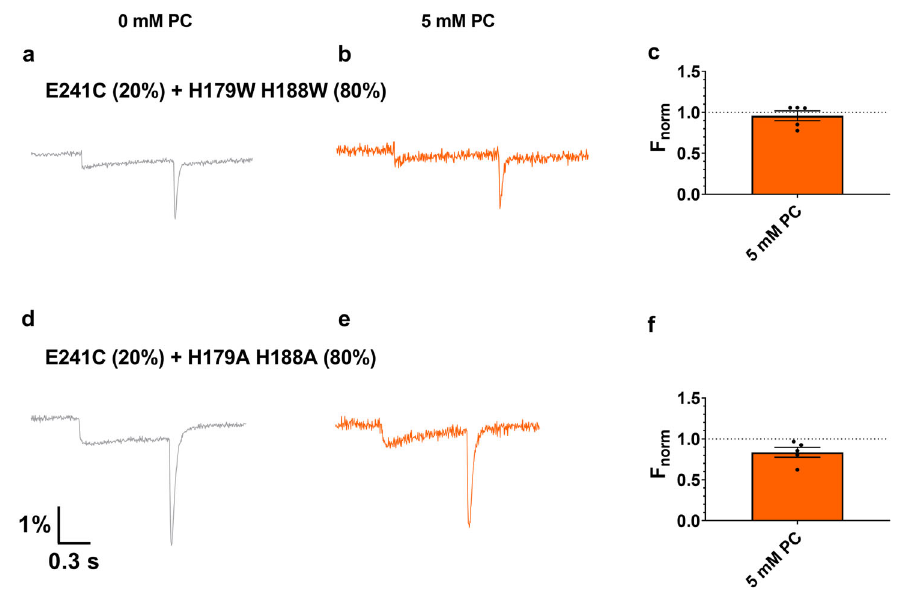
Fig. 6 Fluorescence traces of heterodimer CiHv1. Representative fl uorescence responses to a voltage step from − 60 mV to + 100 mV from oocytes labeled with TAMRA-MTS on E241C in only one subunit of the dimer. The TAMRA-labeled subunit was paired with a subunit which does not contain labelable Cys but two Trp residues ( a , b , c ) or two Ala residues ( d , e , f ) by mixing RNA of E241C subunits (no Trp) with H179W/H188W or H179A/H188A subunits (no Cys) in a 20 – 80% ratio, respectively. a , d panels show the control VCF signals in the absence of PC, while the ( b , e ) panels in the presence of 5 mM PC in the extracellular solution from the same oocyte. Bar charts in panel c , f summarize the average PC effects at 5 mM concentration. Vertical axis shows Δ F tail /F h values, normalized to the control value (0 mM PC). Error bars represent SEM ( N ≥